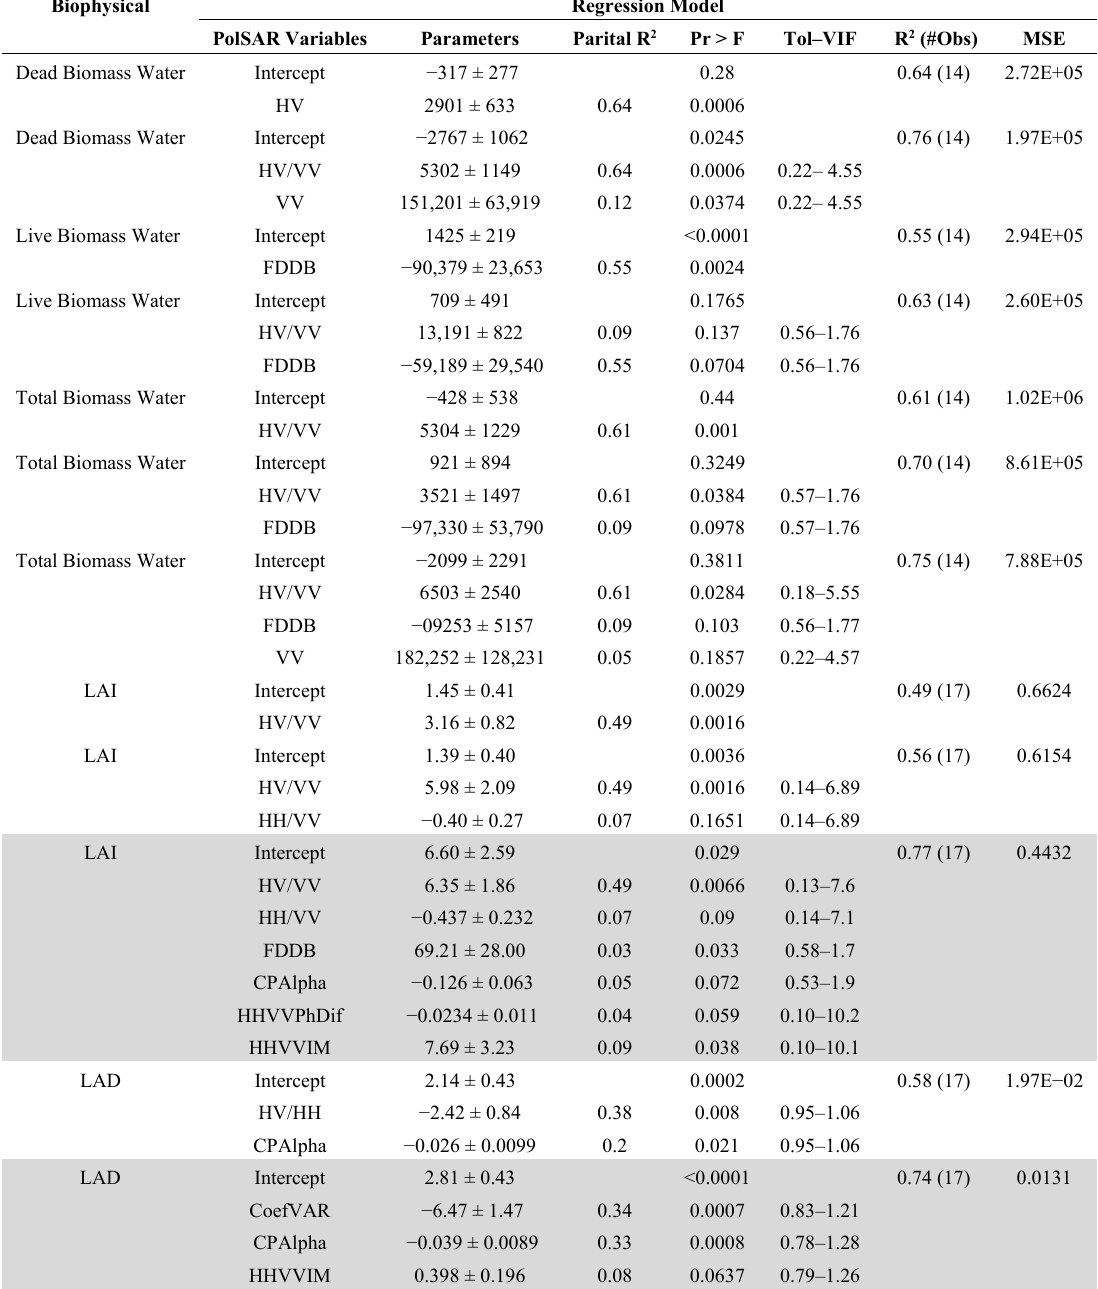
Table 3. Regression models used to estimate the field-based biophysical variables. FDDB = Freeman–Durden Double Bounce, CPAlpha = Cloude–Pottier Alpha angle, HHVVPhDif = Phase difference, HHVVIM = Imaginary Correlation Coefficient, CoefVAR = Coefficient of Variation, MSE = Model Mean Square Error. Highlighted cells denote model parameters used to produce the LAI and LAD